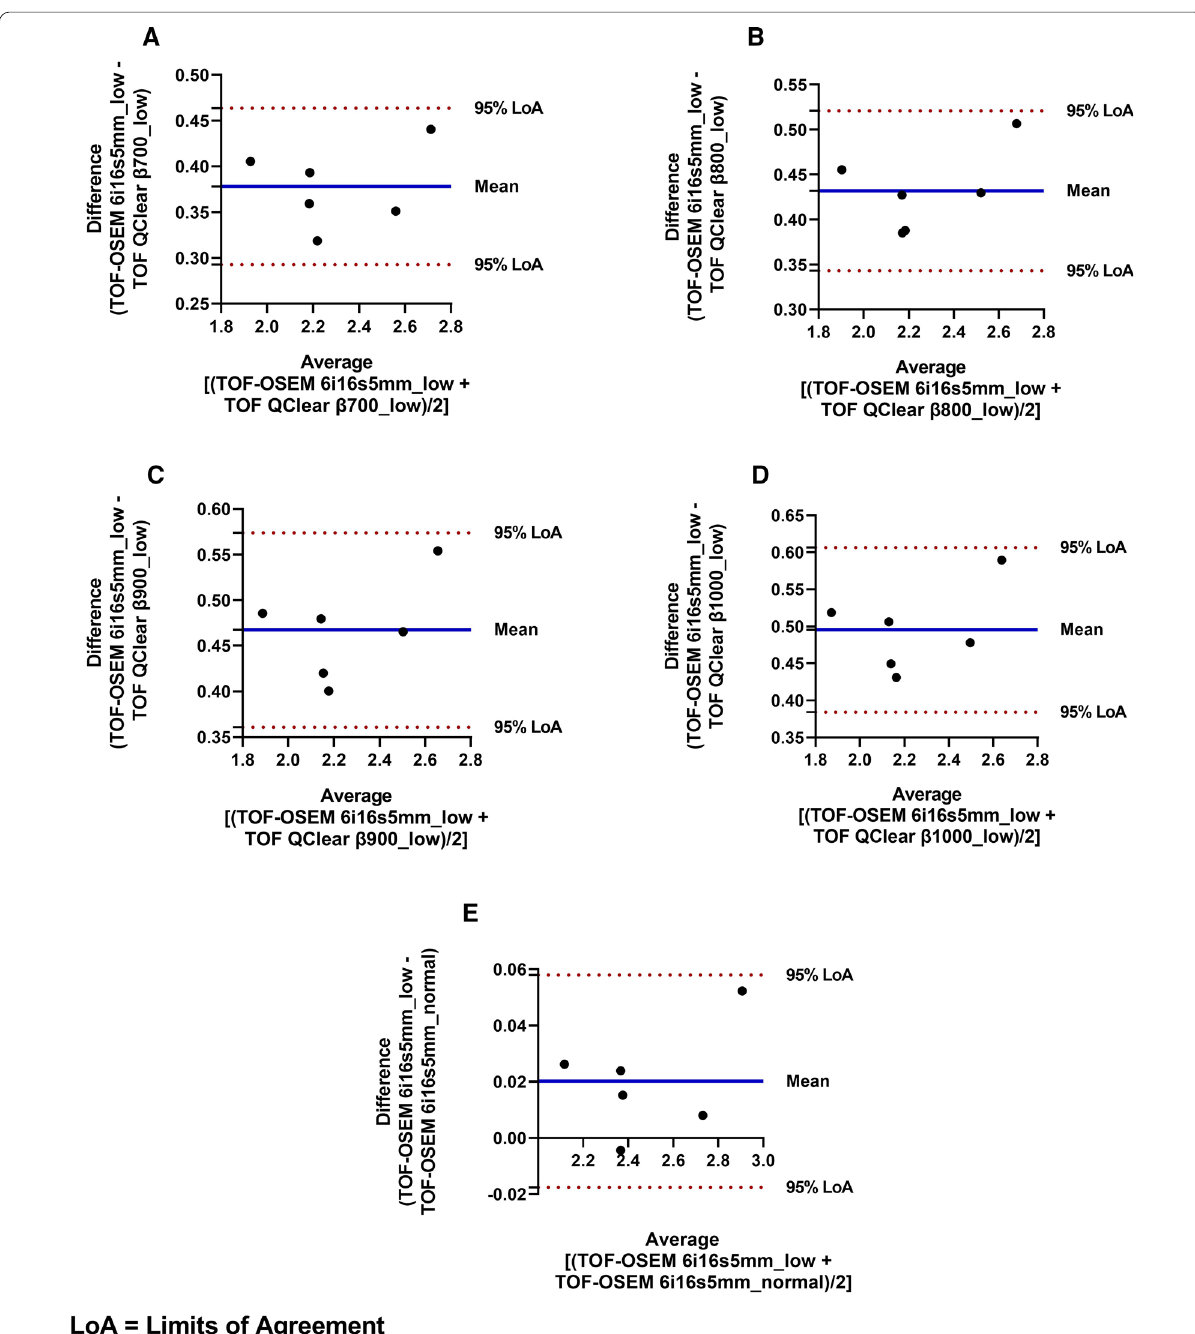
Fig. 4 Bland–Altman plots of the BP ND obtained for the Striatum: A TOF OSEM 6i16s5mm _low versus TOF Q.Clear β700_low; B TOF OSEM 6i16s5mm _low versus TOF Q.Clear β800_low; C TOF OSEM 6i16s5mm_low versus TOF Q.Clear β900_low; D TOF OSEM 6i16s5mm_low versus TOF Q.Clear β1000_low; E TOF OSEM 6i16s5mm _low versus TOF OSEM